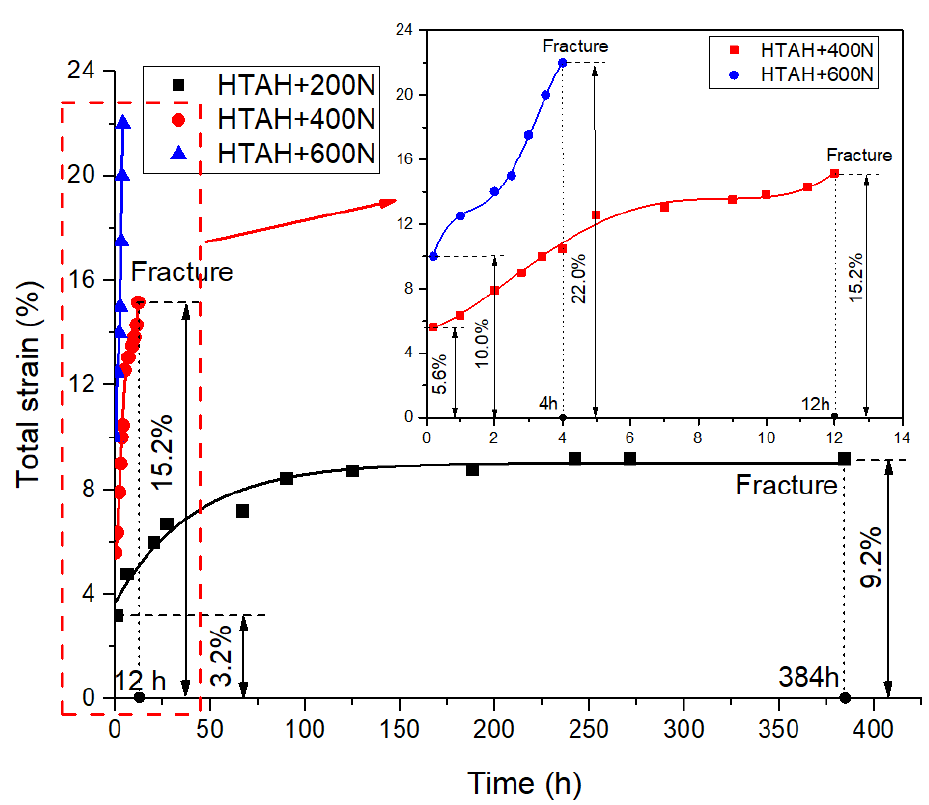
Figure 5. Creep curves in the HTAH environment.